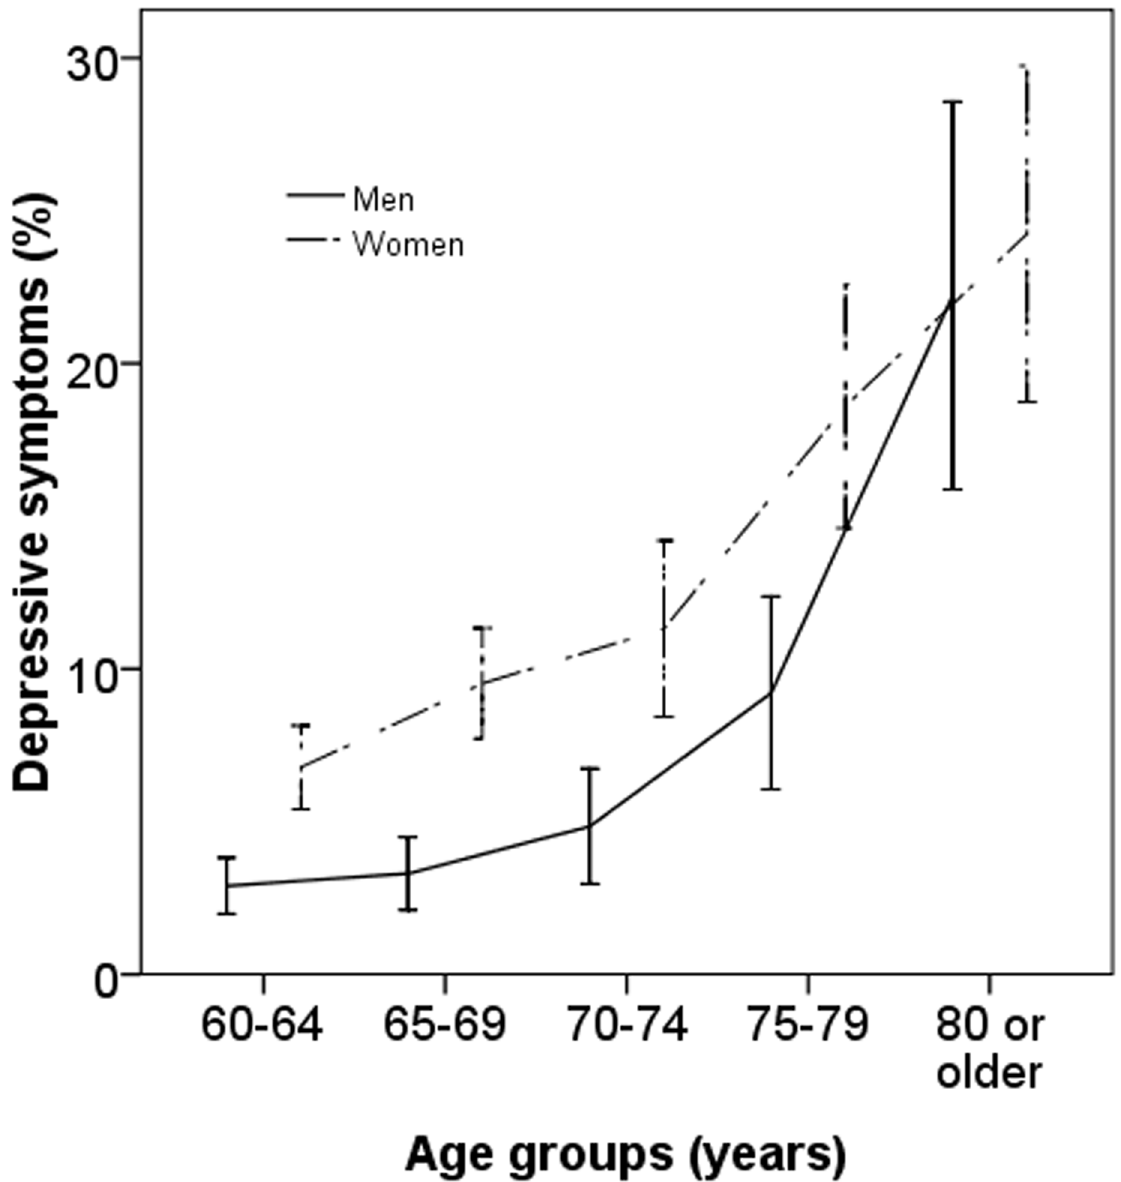
Fig 2. Age-specific prevalenceof depression by